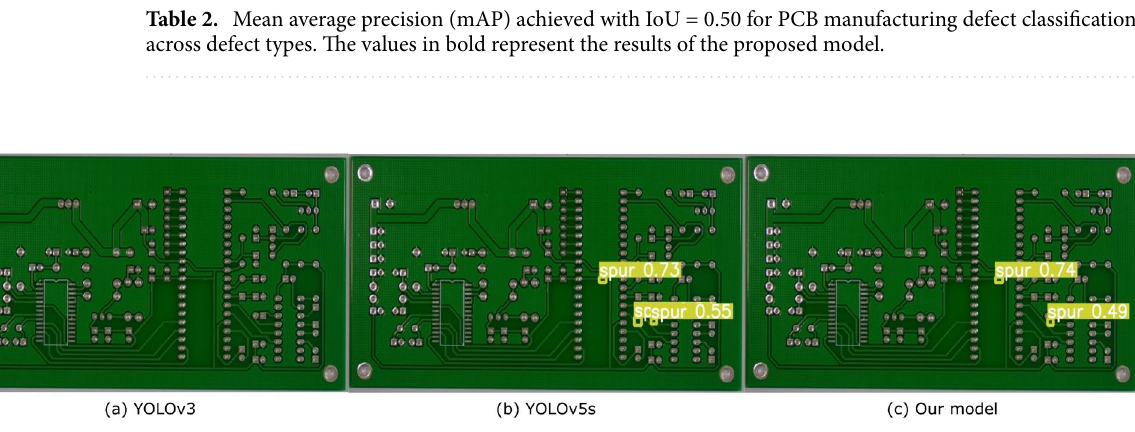
Figure 6. We detected the defects on the bare board PCB using three different models. The studied PCB has 2 spur defects. We observe that YOLOv3 fails to identify the presence of both the spur defects while, YOLOv5s predicts an additional incorrect defect. Our proposed model is able to identify the two correct